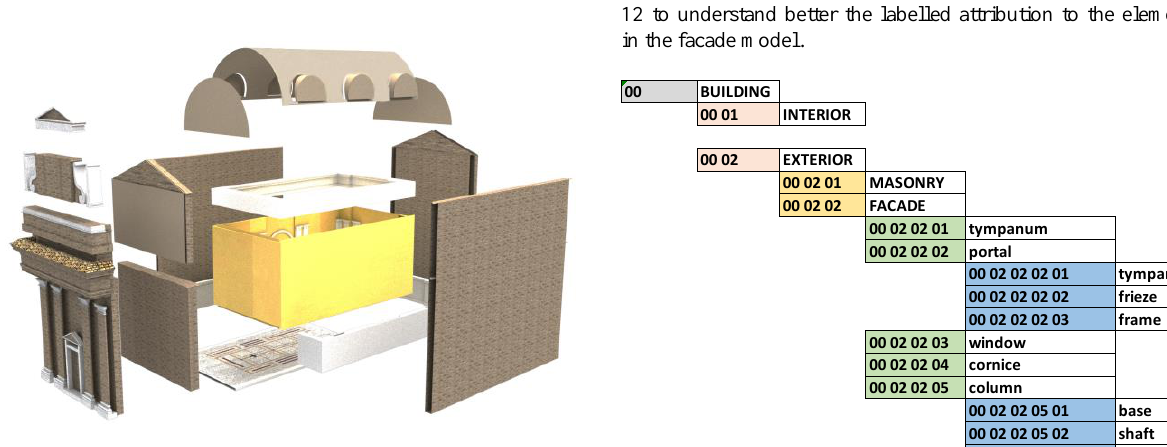
Figure 9. Exploded axonometry of the 3D model showing the architectural components